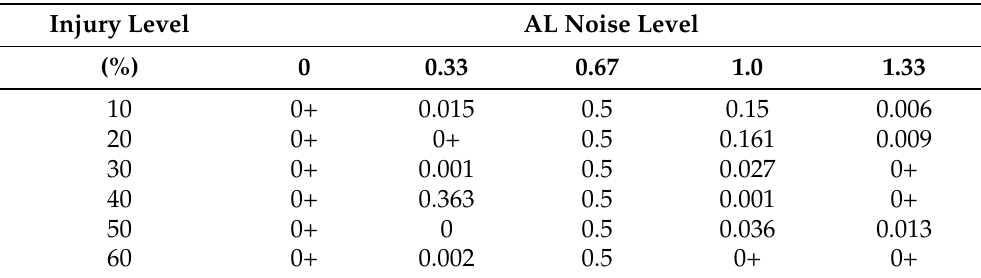
Table A1. P -values for normalized post-injury effects of increased AL noise, on top-scoring responses (see Figure 6A). p -values are for a given AL noise vs. AL noise = 0.67 (i.e., the middle value). “0+” indicates p -value < 0.0005. N = 98 to 112 (mean = 107).